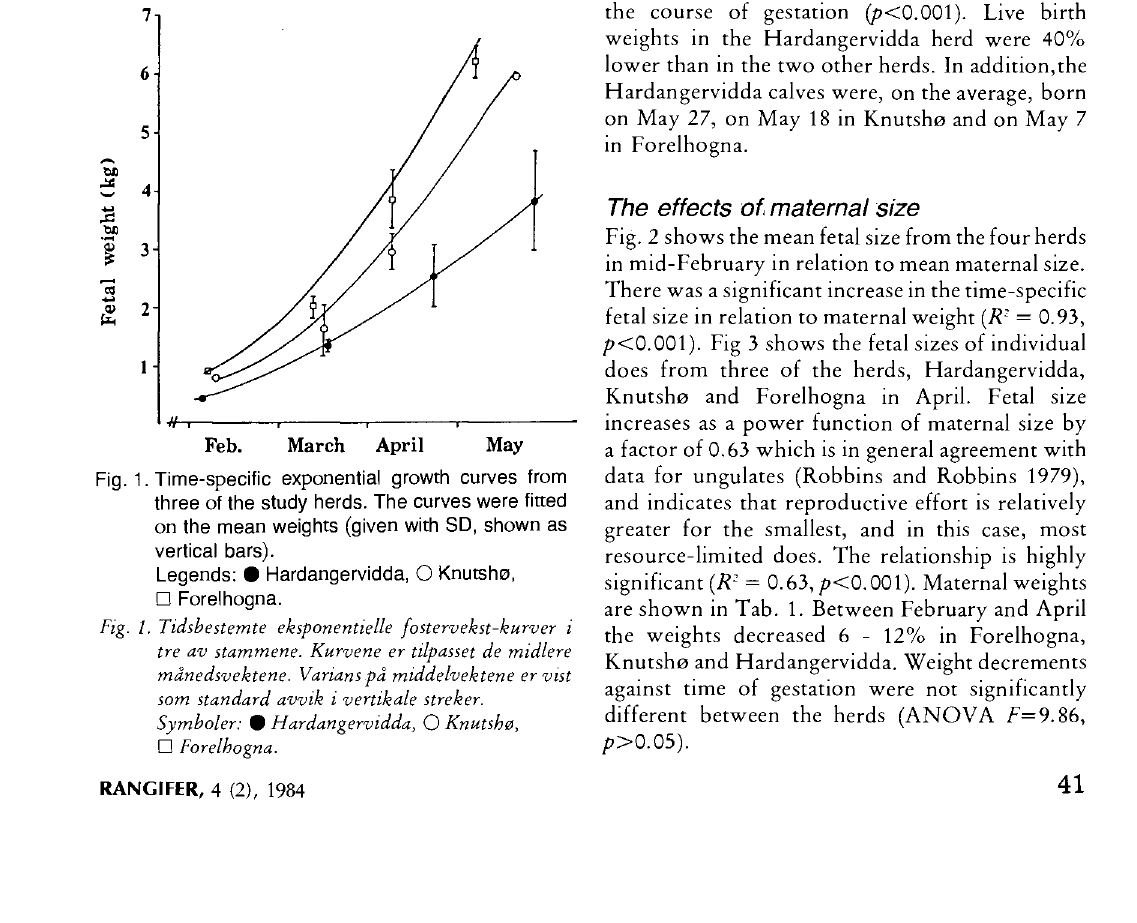
Fig. 2. Mean fetal weights in February in relation to mean maternal dressed weights. Fig. 2. Gjennomsnittlige fostervekter i februar i forhold til gjennomsnittlige slaktevekter hos simlene.